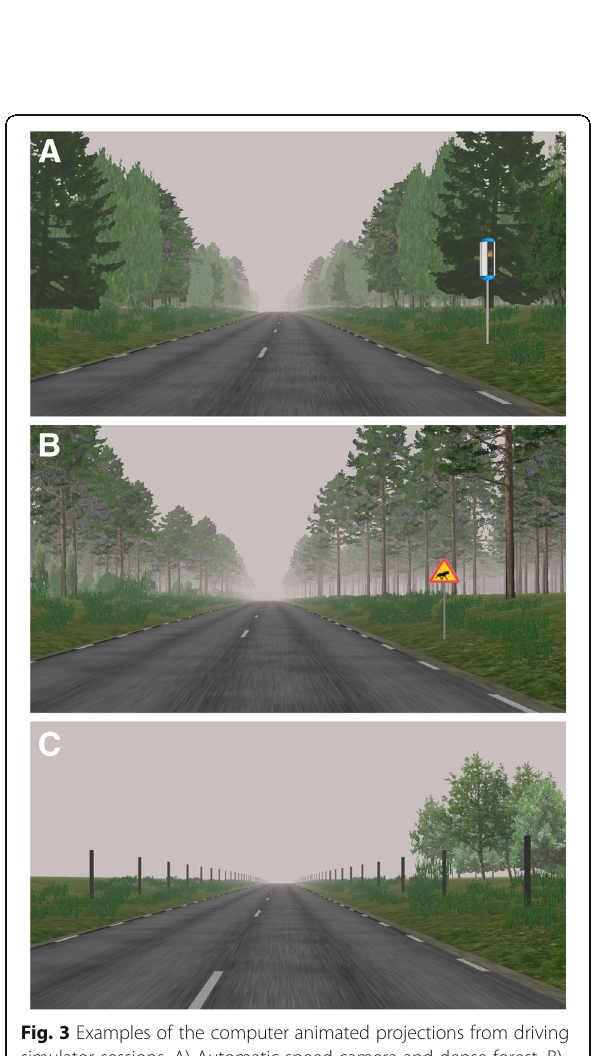
Fig. 3 Examples of the computer animated projections from driving simulator sessions. A) Automatic speed camera and dense forest, B) wildlife warning sign and dense forest, and C) wildlife fence and open